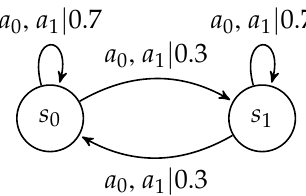
Figure 1. Environment, depicted in terms of a finite automaton.